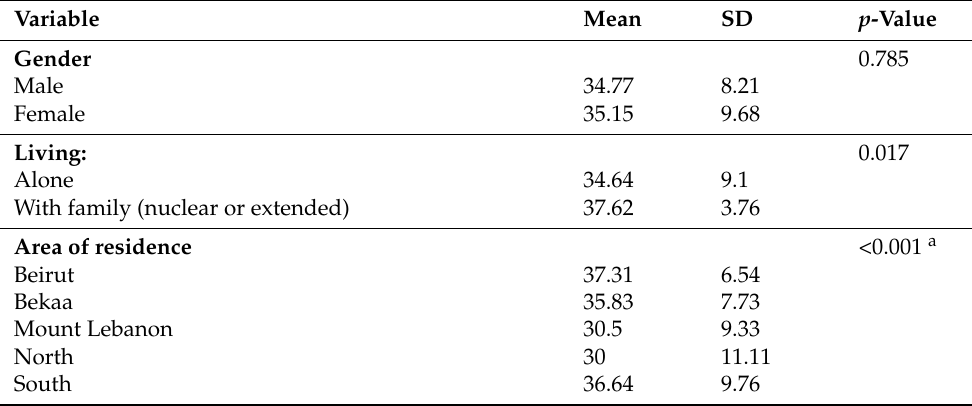
Table 5. Bivariate analysis of sociodemographic, socioeconomic, stroke parameters, and clinical characteristics of the patients, taking the LMAS-14 as the dependent